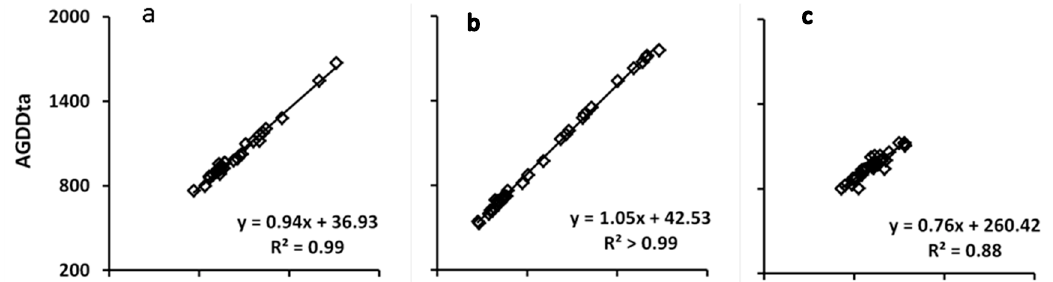
Figure 12. Cont. Figure 12.